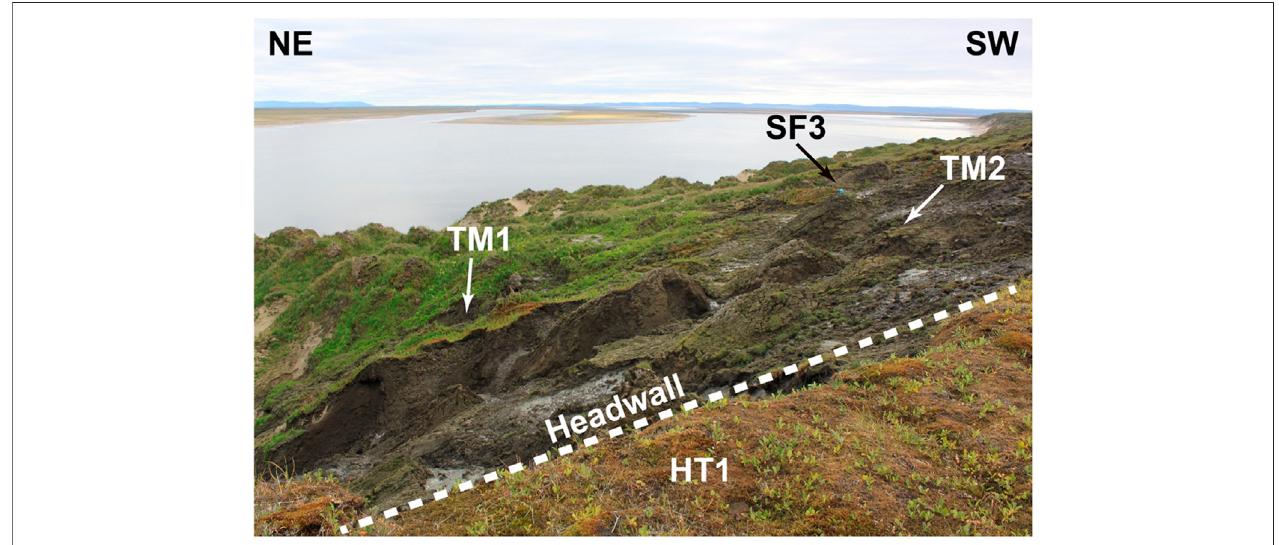
FIGURE 1 | Study sites on the retrogressive thaw slump on Kurungnakh Island including two thaw mounds (TM) in Pleistocene Yedoma, a site on the slump fl oor (SF) where sediments were mixed, and the Holocene terrace (HT).